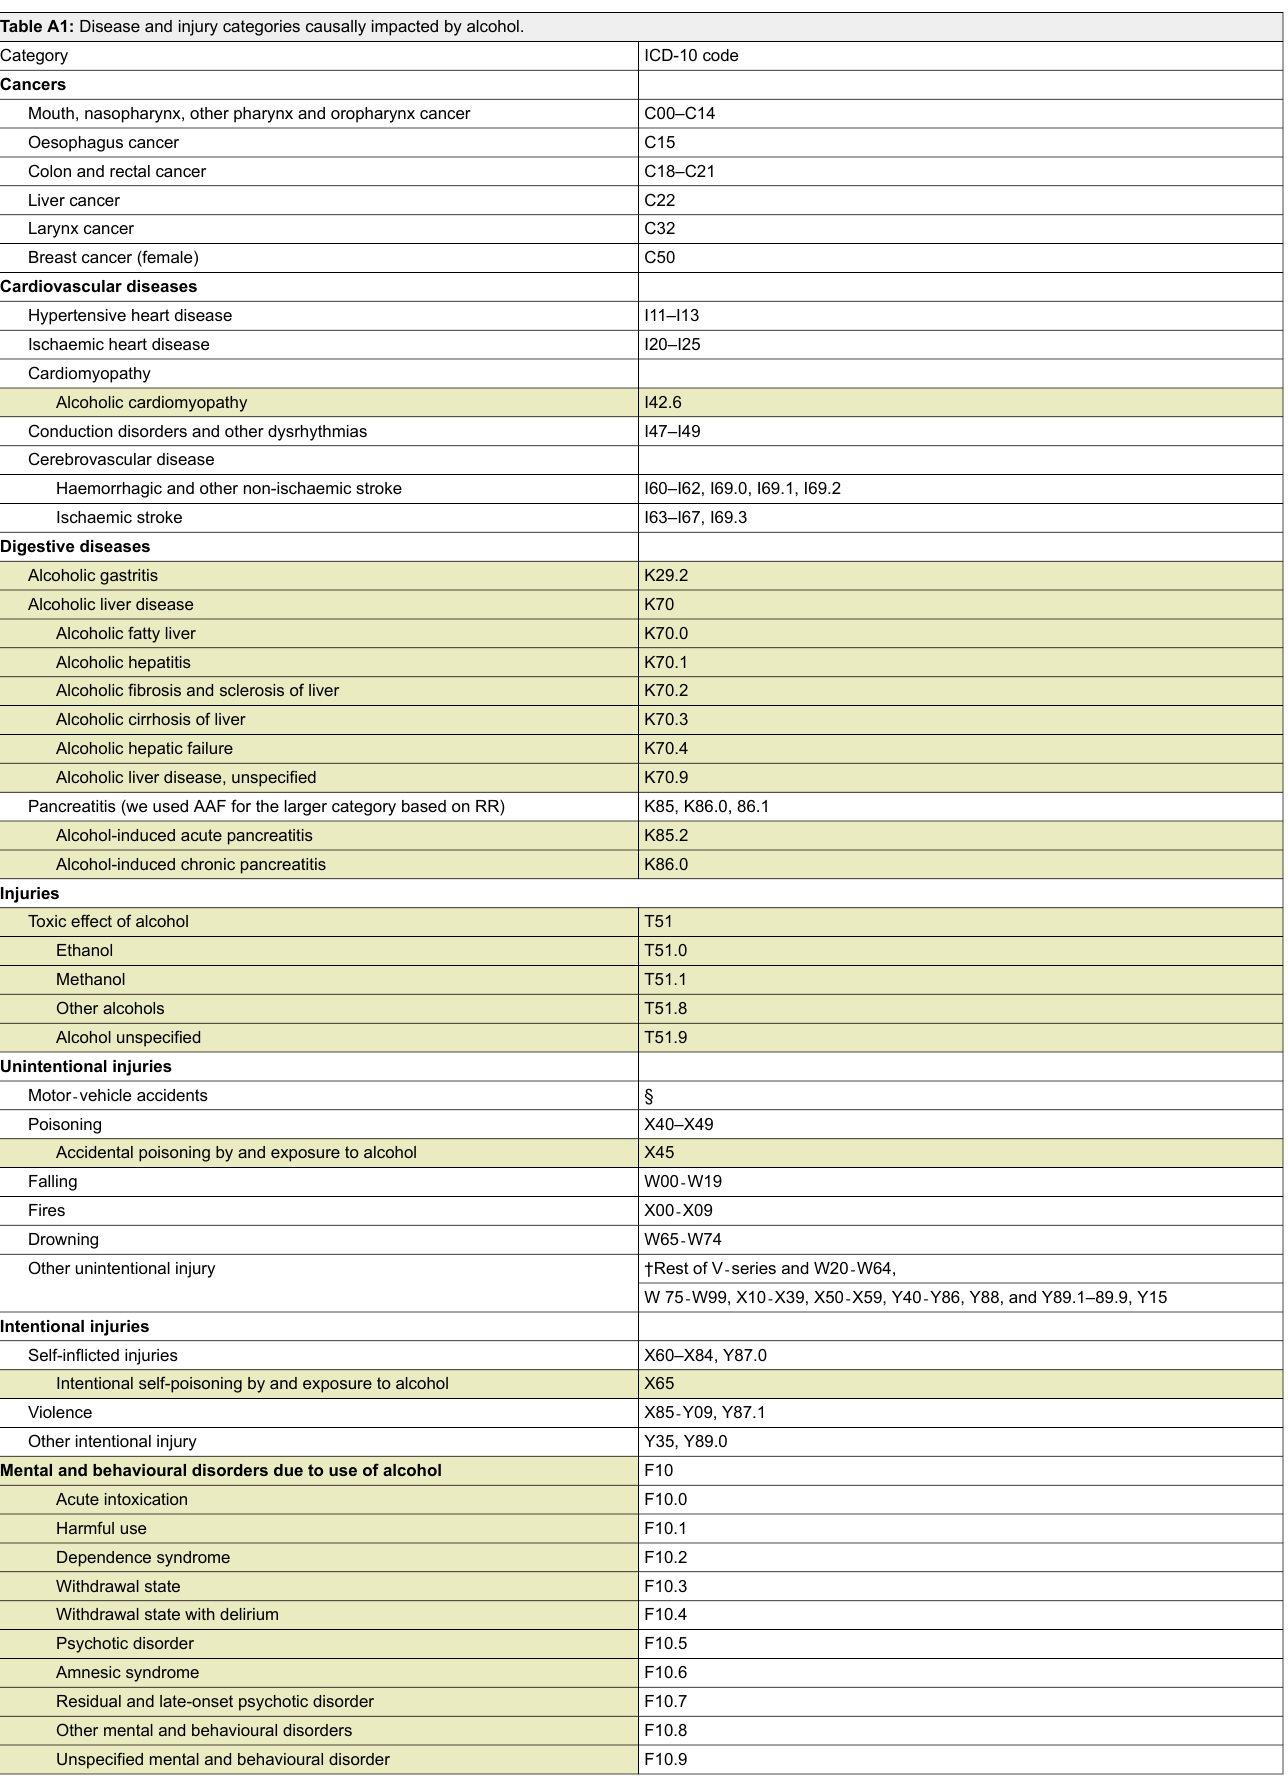
Table A1: Disease and injury categories causally impacted by alcohol.